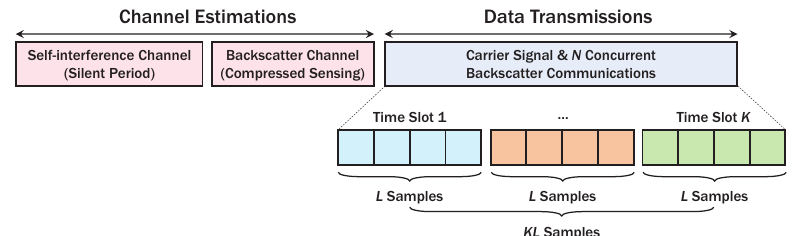
Figure 2. Link layer protocol for AmBC with sparse